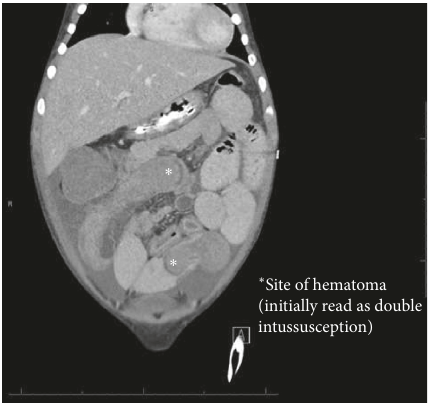
Figure 2: Coronal CT.